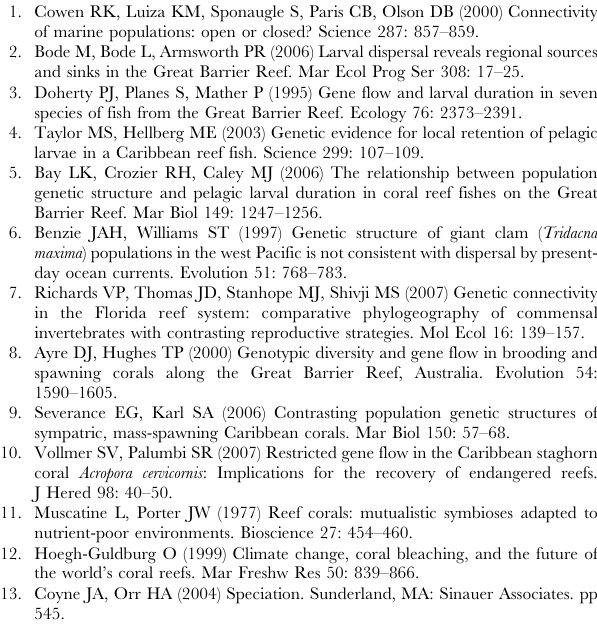
Table S2 Temporal patterns of Symbiodinium ITS2 ‘‘type(s)’’ and multilocus microsatellite genotype(s) from tagged M. annularis colonies sampled between 2003 and 2005 in the Upper Florida Keys and Exuma